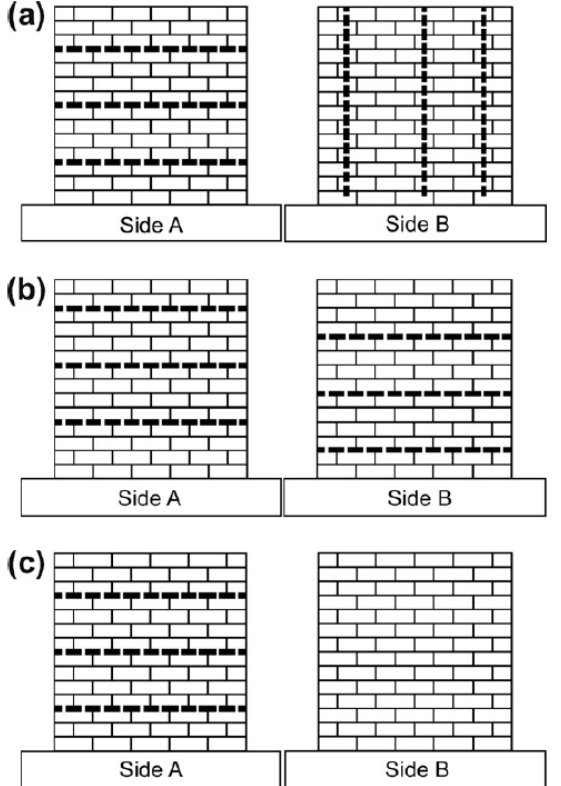
Figure 4. CFRP retrofitting schemes [58]: ( a ) Scheme 1—three horizontal strips on one side and three vertical strips on the other side, ( b ) Scheme 2—six horizontal strips, three on each side, and ( c ) Scheme 3—three horizontal strips on one side only. Reproduced with permission from Konthesingha, K.M.C., Masia, M.J., Petersen, R.B., Mojsilovic, N., Simundic, G., and Page, A.W. Static cyclic in-plane shear response of damaged masonry walls retrofitted with NSM FRP strips— An experimental evaluation; published by Elsevier, Engineering Structures,